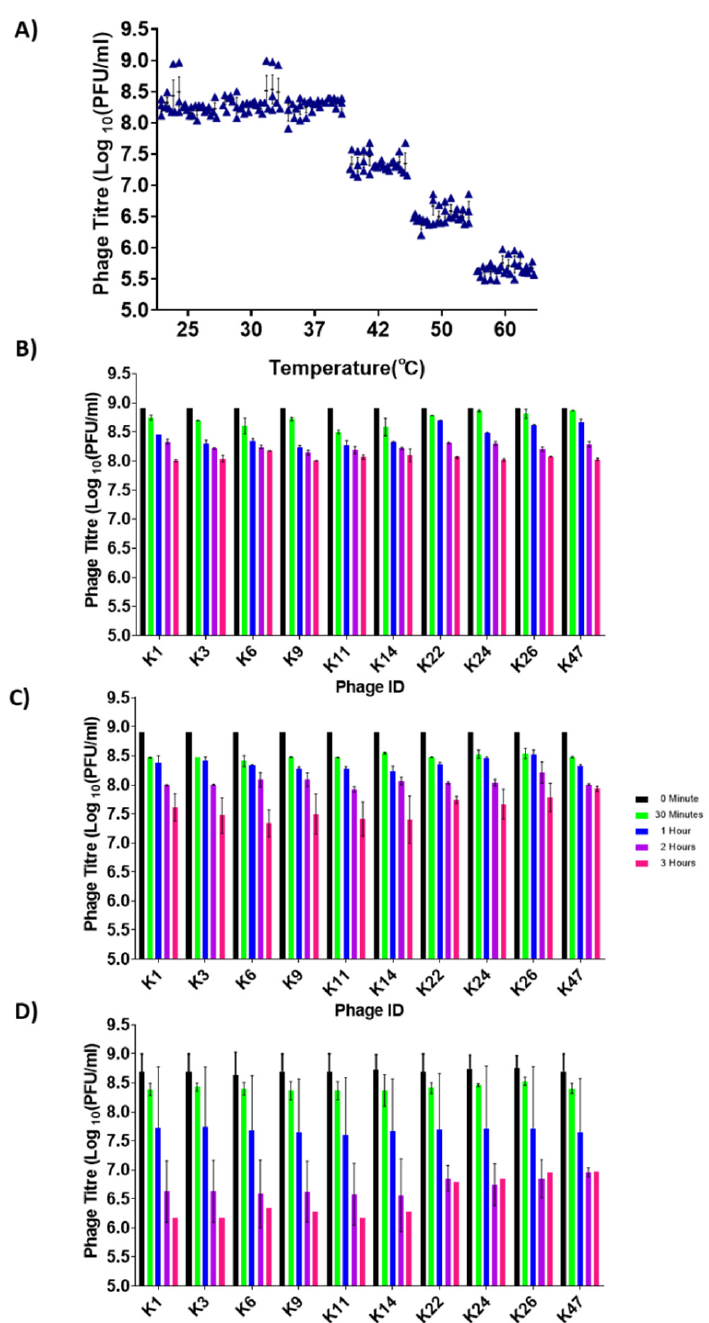
Figure 4. Phage thermal stability assay. ( A ) Overall stability of S . Enteritidis phages at 25 ◦ C, 30 ◦ C, 37 ◦ C, 42 ◦ C, 50 ◦ C, and 60 ◦ C for 12 h. The black triangle indicates individual replicate values of phages on each bar graph. The graph indicates phage titres after 12 h of incubation. ( B ) Phage stability at 37 ◦ C after 3 h of incubation. The individual phage titres were determined after 0, 0.5, 1, 2, and 3 h. ( C ) Phage stability at 42 ◦ C after 3 h incubation. The individual phage titres were determined after 0, 0.5, 1, 2, and 3 h. ( D ) Phage stability at 50 ◦ C after 3 h of incubation. The individual phage titres were determined after 0, 0.5, 1, 2, and 3 h. All experiments were repeated twice and measured in triplicate. Error bars represent the standard error of the mean (±SE).